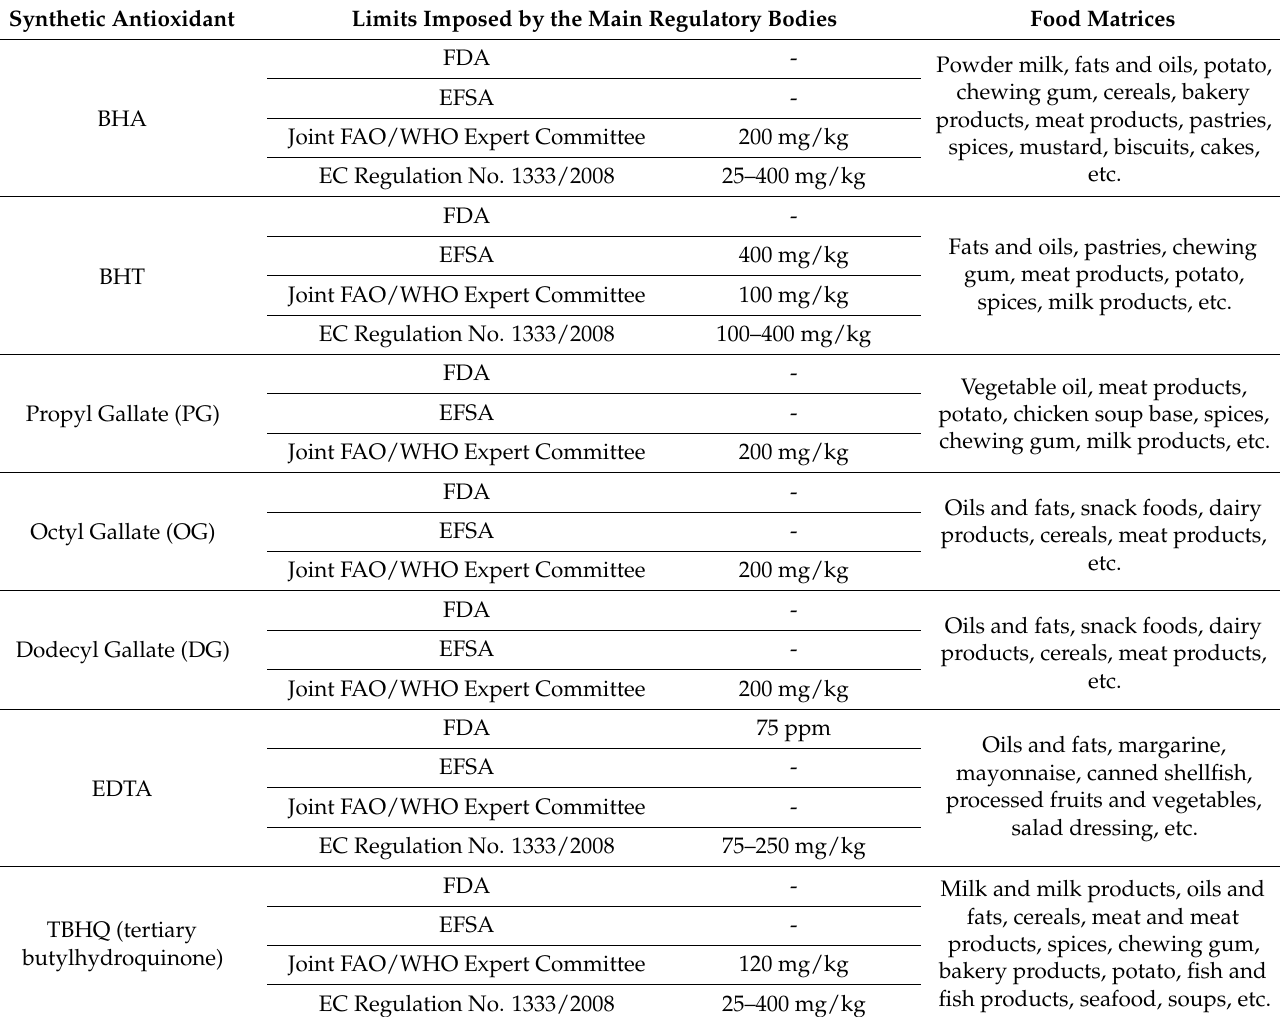
Table 2. The limits imposed by the regulatory bodies for the main synthetic antioxidants used in the food industry